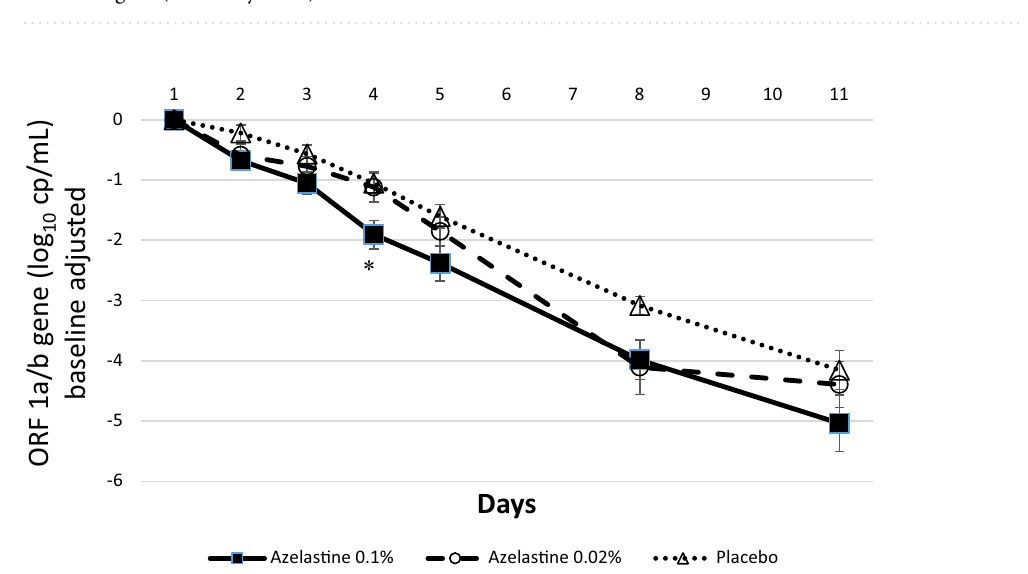
Figure 3. Absolute changes in viral copy numbers (log 10 cp/ml) from baseline (day 1) over time based on the ORF 1a/b gene (Ct < 25 analysis set). * p = 0.005 comparing the decrease of viral load on day 4 in the 0.1% azelastine group (log 10 1.90 ± 1.03) compared to placebo (log 10 1.05 ± 0.70; p =